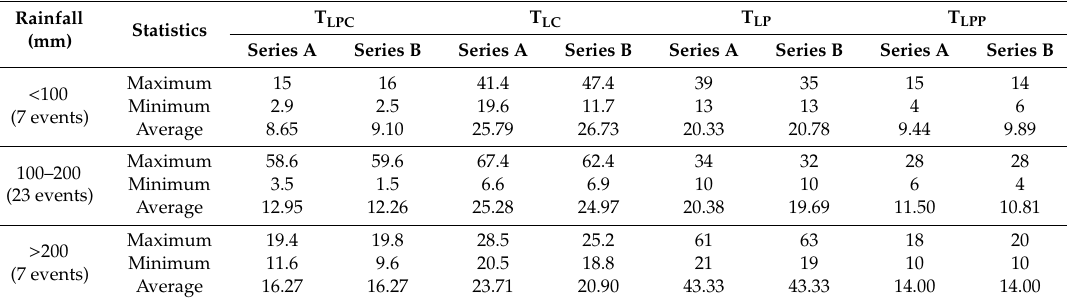
Table 11. The lag times for di ff erent